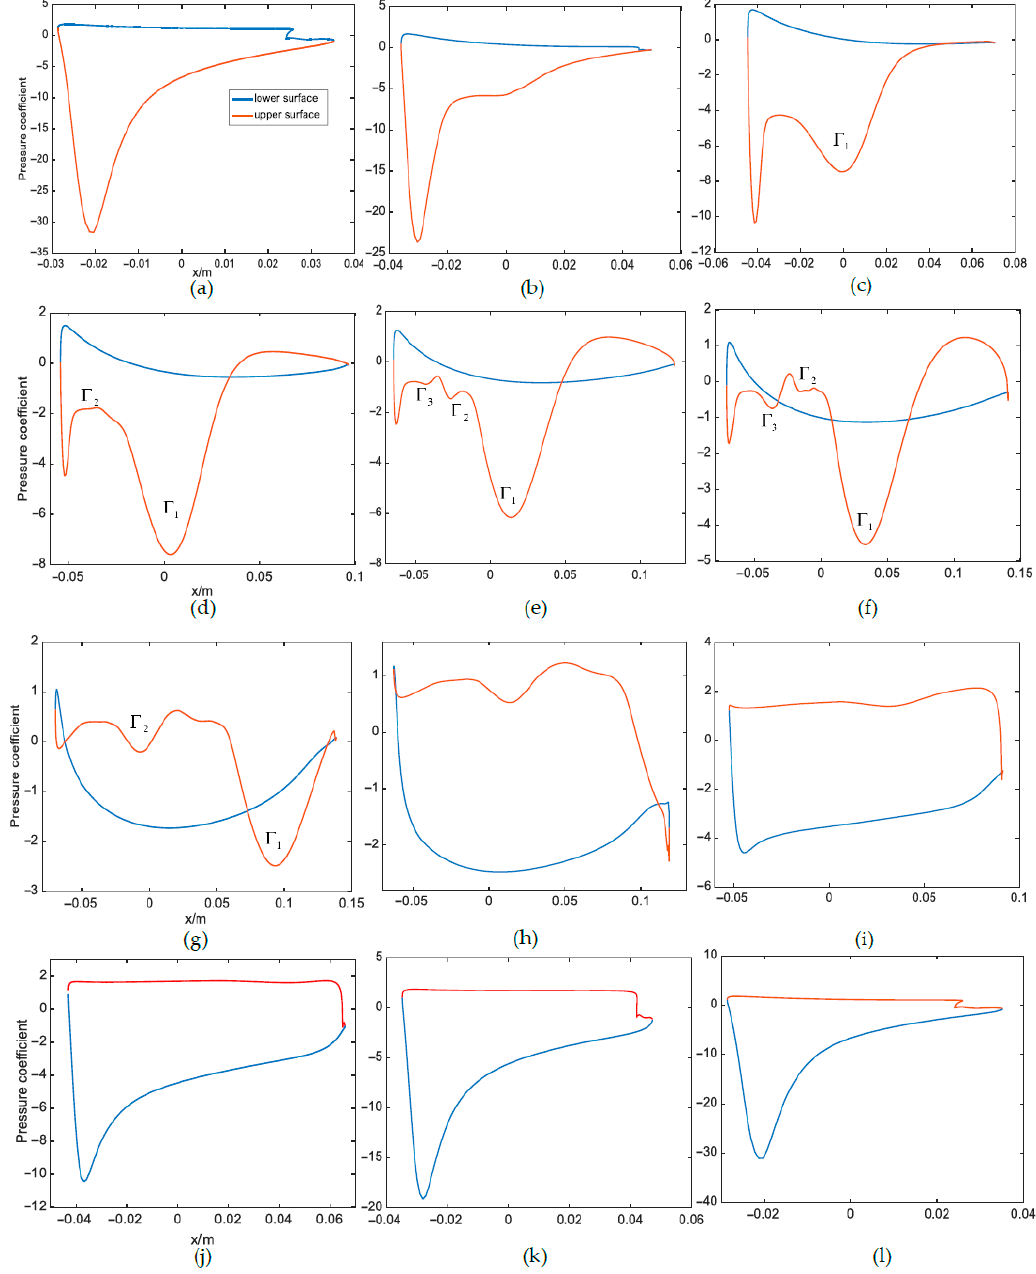
Figure 8. Distribution of the pressure coefficient along the flexible hydrofoil surfaces ( n = 5, δ c = 0.1 c , f * = 0.13) in the half-cycle. ( a ) θ = − 72 ◦ , ( b ) θ = − 65 ◦ , ( c ) θ = − 56 ◦ , ( d ) θ = − 45 ◦ , ( e ) θ = − 31 ◦ , f * = 0.13) in the half-cycle. ( a ) θ = –72 ° , ( b ) θ = –65 ° , ( c ) θ = –56 ° , ( d ) θ = –45 ° , ( e ) θ = –31 ° , ( f ) θ = –16 ° , ( f ) θ = − 16 ◦ , ( g ) θ = 16 ◦ , ( h ) θ = 31 ◦ , ( i ) θ = 45 ◦ , ( j ) θ = 56 ◦ , ( k ) θ = 65 ◦ , ( l ) θ = 72 ◦ ( g ) θ = 16 ° , ( h ) θ = 31 ° , ( i ) θ = 45 ° , ( j ) θ = 56 ° , ( k ) θ = 65 ° , ( l ) θ = 72 ° .